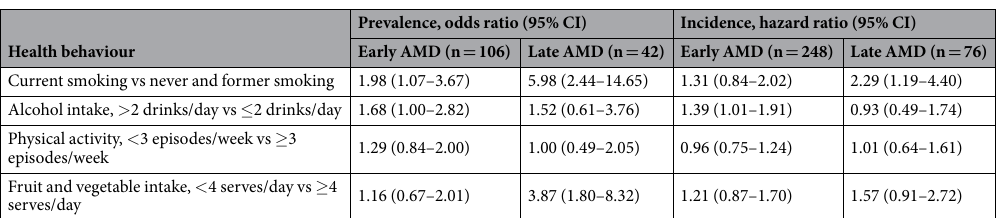
Table 2. Individual health behaviours in relation to the prevalence and 15-year incidence of AMD in the Blue Mountains Eye Study. CI – confidence interval; a Adjusted for age, sex, white cell count, and fish consumption. b One serve of vegetables and fruits is specified as 75 grams and 150 grams, respectively 24 . Poor dietary behaviour was defined as having had fruits and/or vegetables less than 4 serves